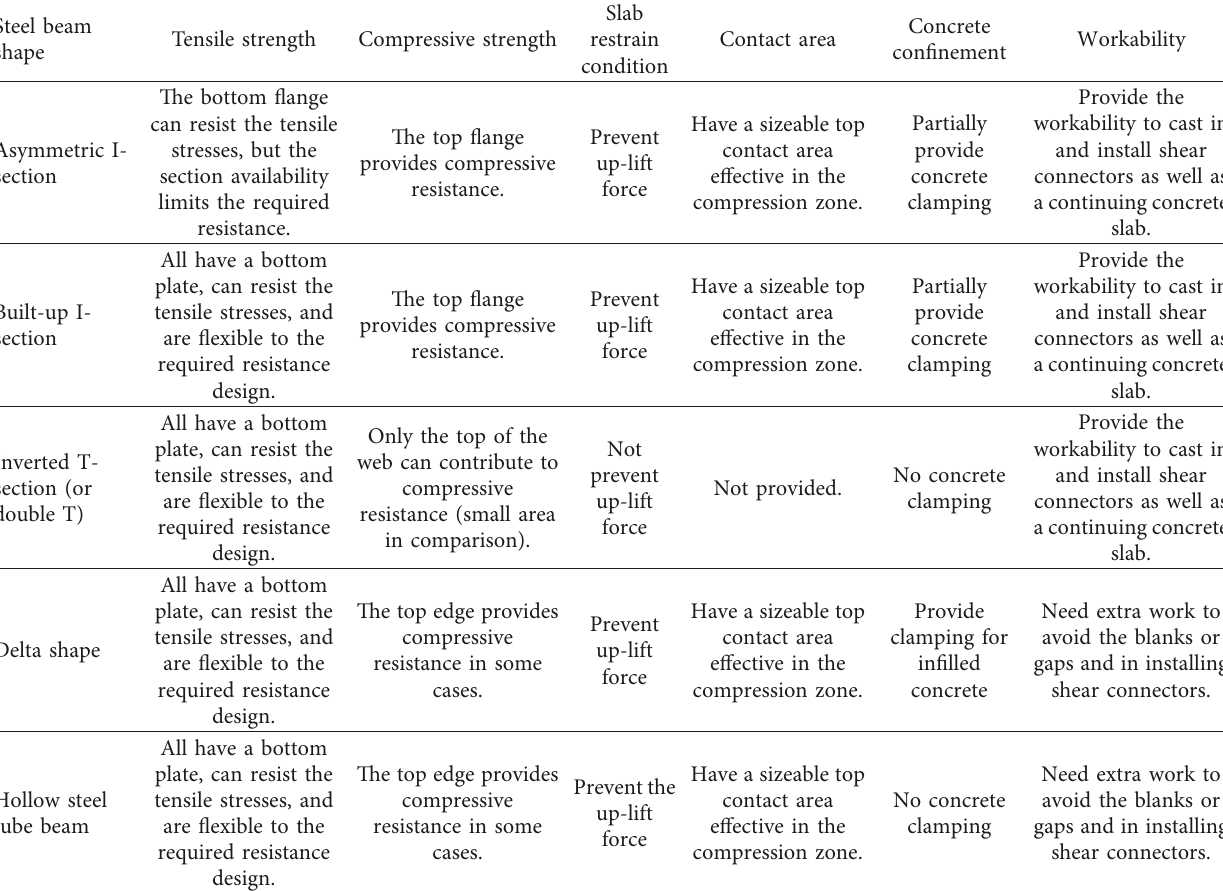
Table 1: Comparison of steel beam shapes used in the composite slim floor